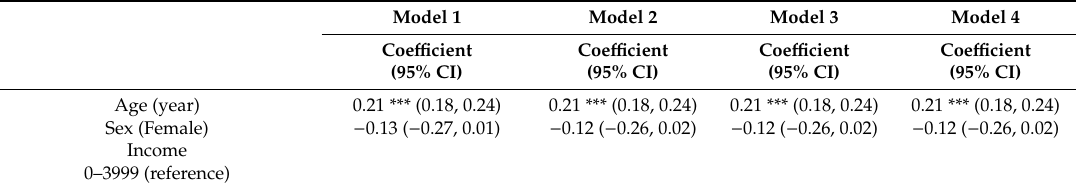
Table 4. Multilevel linear analysis of factors associated with changes in height-for-age z-score (HAZ) over one year among 772 preschool children in